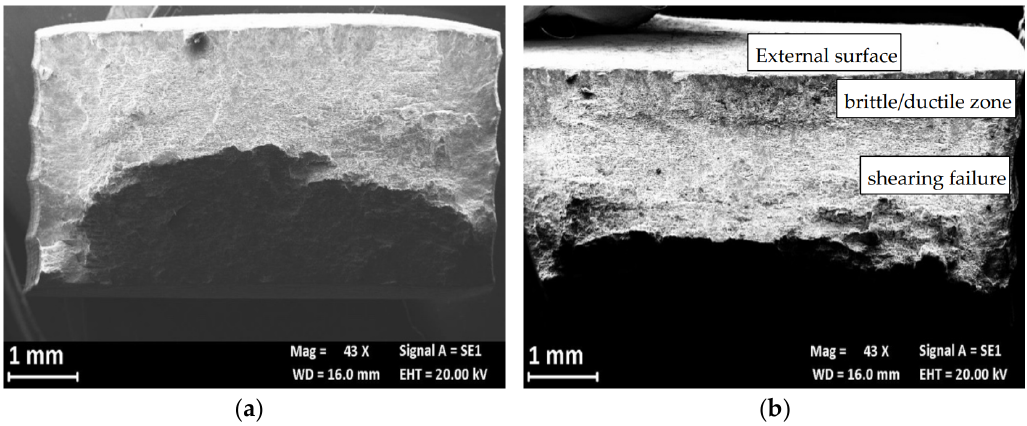
Figure 14. SEM image of the fracture surface of the AA7075 T6 specimen after the SSR test ( a ) macro at air, ( b ) macro in 0.6 M NaCl solution.